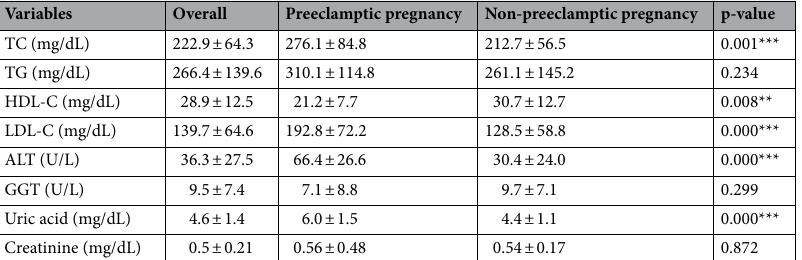
Table 4. Levels of abnormal biochemical markers in preeclamptic and non-preeclamptic participants. Data are presented as % or mean ± SD. p-values are obtained from Independent sample t-test in comparison between preeclamptic and non-preeclamptic groups. Values greater than the reference range are denoted as “elevated” 44 . TC total cholesterol, TG triglyceride, HDL-C high density lipoprotein cholesterol, LDL-C low density lipoprotein cholesterol, ALT alanine aminotransferase, GGT gamma glutamyltransferase. *p < 0.05; **p < 0.01; ***p <